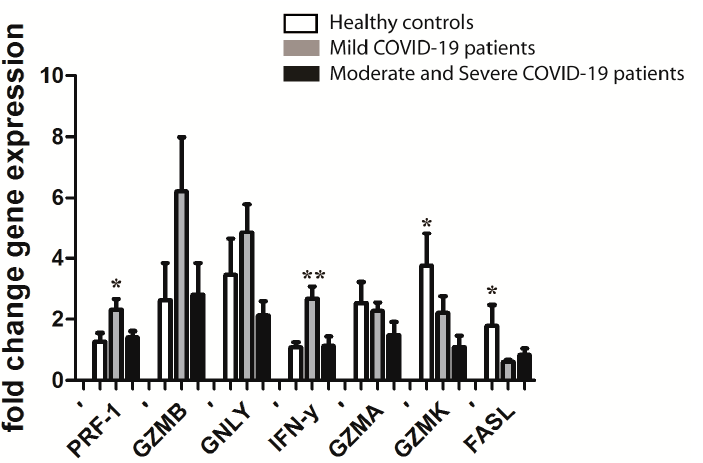
Figure 4. Real-time PCR mRNA fold change of PRF1, GZMB, GNLY, IFN- γ , GZMA, GZMK, and FASL in CD8+ T cells from the peripheral blood of three groups of analyzed participants (stabile mild COVID-19 patients, n = 9; COVID-19 patients progressed to moderate and severe disease after 10th day, n = 7; and healthy controls, n = 9). Data is presented as mean value ± standard deviation. Significant differences are indicated by * p < 0.01, ** p < 0.001 (one-way ANOVA test followed by Tukey or Kruskal–Wallis test followed by Dunn’s multiple comparison test).